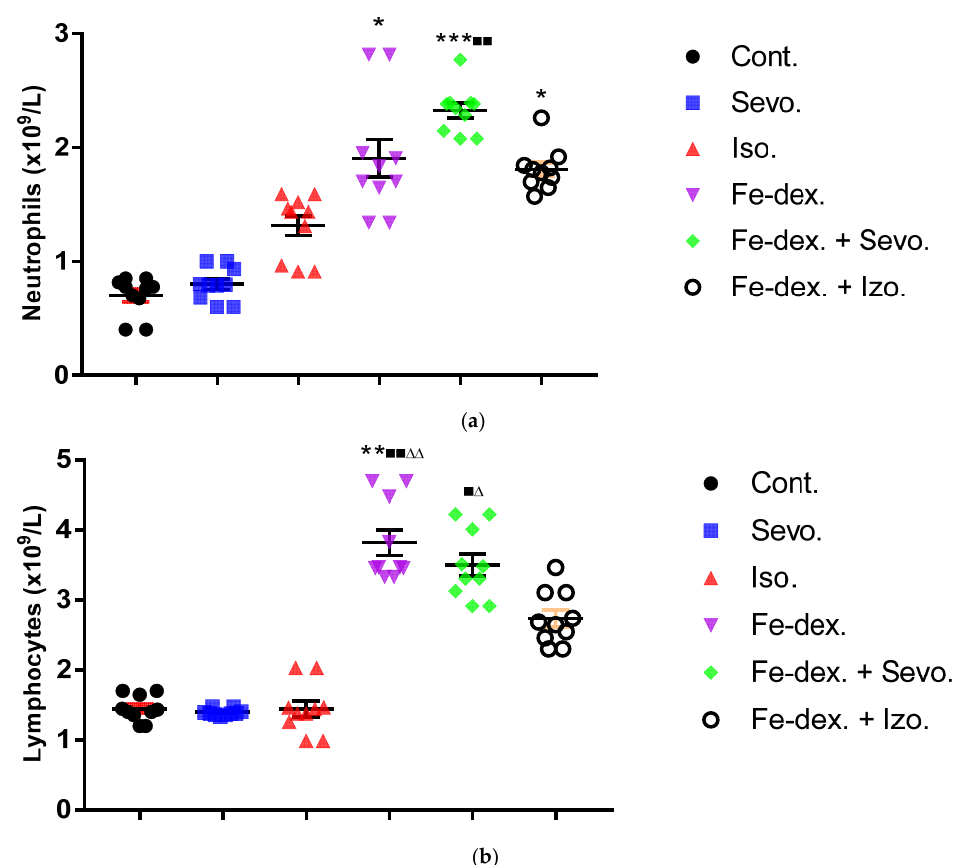
Figure 4. Total number of neutrophils ( a ) and lymphocytes ( b ) in the blood of rats treated with inhaled anesthetics and iron dextran and their combination. Rats ( n = 10 per group) were treated with ip injection of iron dextran (50 mg/kg), exposed to 2.4 vol % sevoflurane inhalation and 1.3 vol % isoflurane inhalation, and exposed to a combination thereof where inhaled anesthetics were given 2 h after ip injection of iron dextran. Animals were treated every other day for 28 days. Each animal sample is indicated by a single dot. The results are expressed as the mean value of each experimental group ± SE. * Statistically significant compared to the control group (* p < 0.05; ** p < 0.01; *** p < 0.001); ■ Statistically significant compared to the sevoflurane group ( ■ p < 0.05; ■■ p < 0.01); ∆ Statisti-